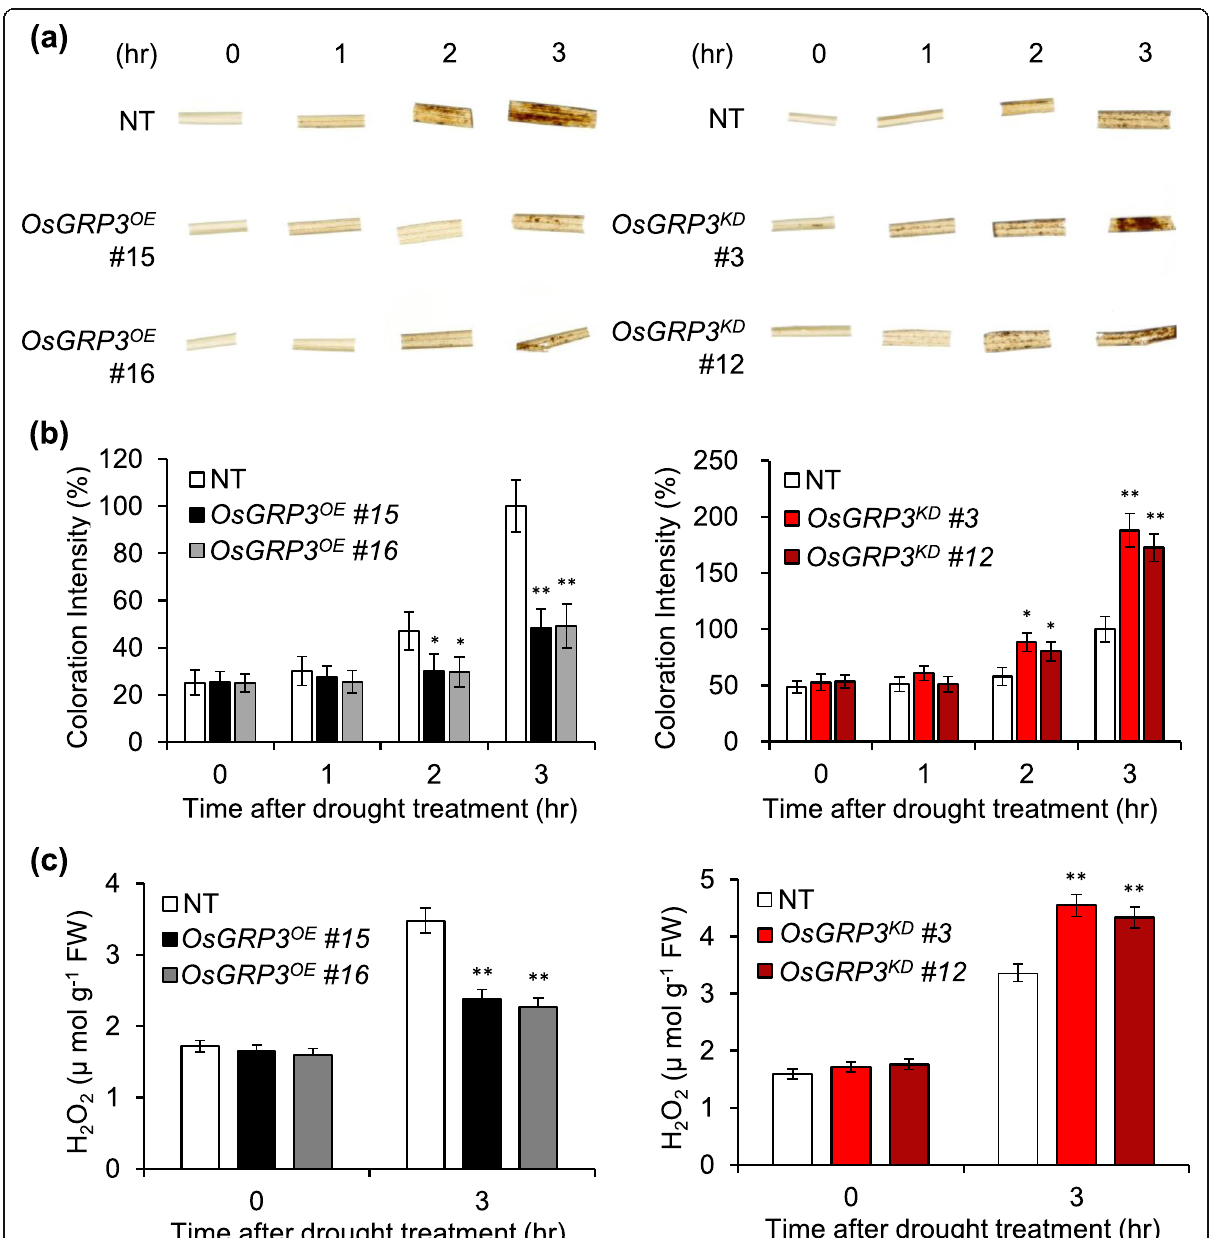
Fig. 7 Assessment of relative H 2 O 2 levels in OsGRP3 transgenic rice plants under drought conditions. a Levels of H 2 O 2 in leaves of two-week-old rice seedlings were visualized by DAB staining with time-course after drought treatment (airdrying). b Histograms depicting relative quantity of H 2 O 2 in terms of their coloration intensity c Measurement of H 2 O 2 levels in leaves of two-week-old rice seedlings after drought treatment (airdrying). The data represent the mean value ± standard deviation (SD) of three biological replicates ( n = 3). Asterisks indicate a statistically significant difference compared with NT. * P < 0.05, ** P < 0.01; One-way